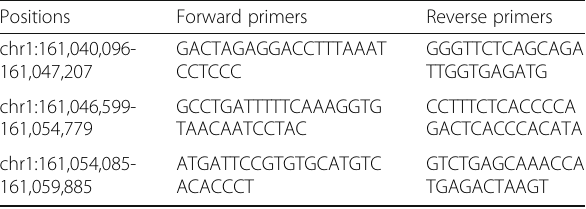
Table 2 PCR primers used for genomic sequencing Positions Forward primers Reverse